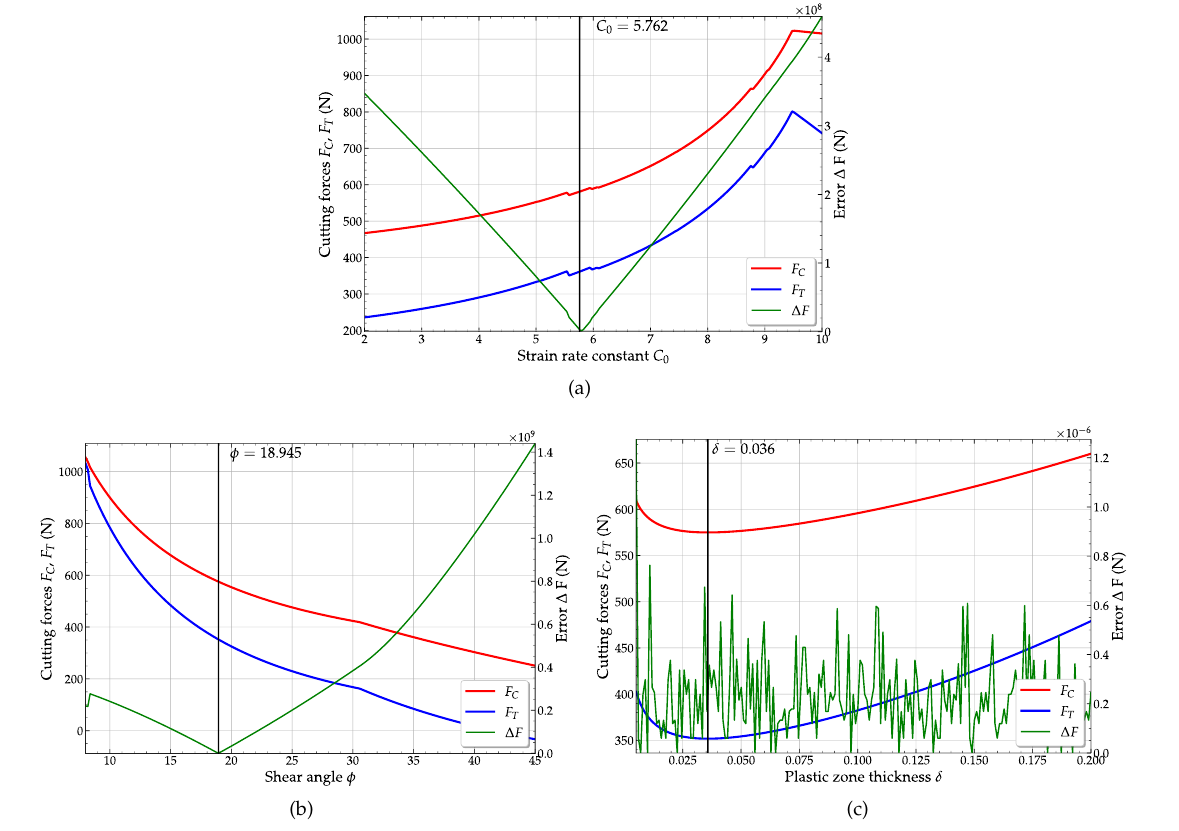
Figure 6. Cutting forces F C , F T and equilibrium error ∆ F evolution vs. strain rate constant C 0 ( a ), vs. shear angle φ ( b ), and vs. plastic zone thickness δ ( c